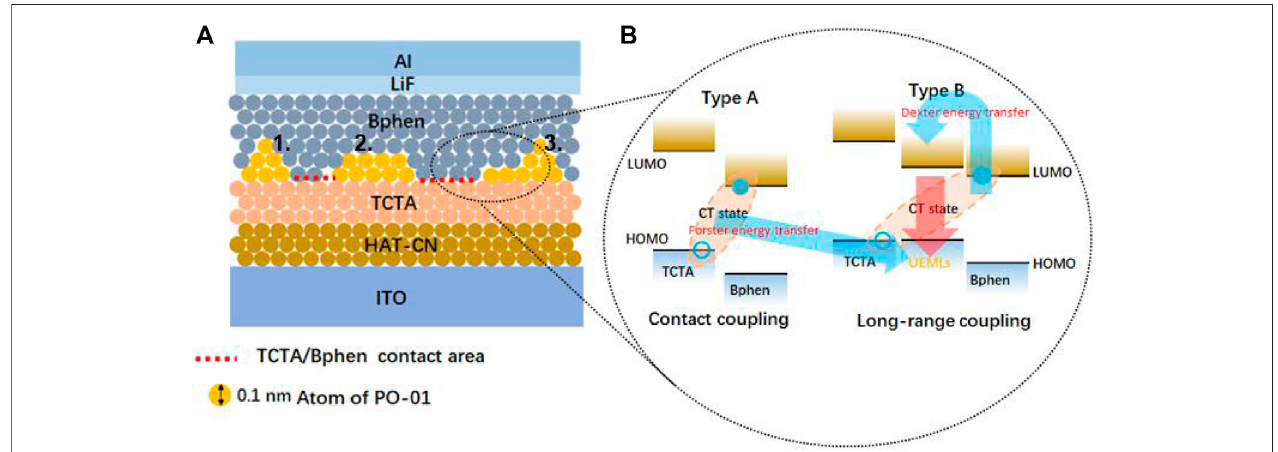
FIGURE1|(A) Thin fi lmsgrowsketchdiagrammodesofultrathinemittingnanolayers(1.Volmer – Weber,2.Frank – vanderMerwe,and3.Stranski – Krastanov)and (B) the ultrathin emitting nanolayers and their energy processes within the exciplex (Type A. and Type